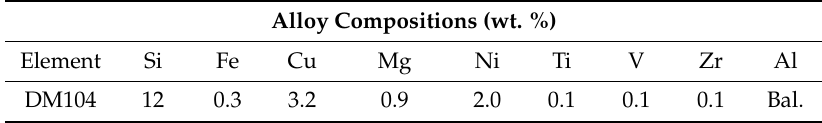
Table 1. Chemical composition of the alloy studied. Alloy Compositions (wt. %)